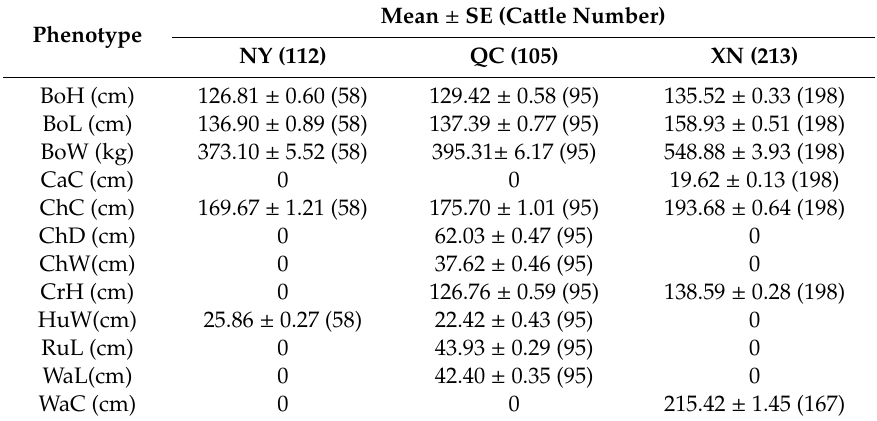
Table 2. Statistics of Nanyang (NY), Qinchuan (QC) and Xianan (XN) cattle for twelve